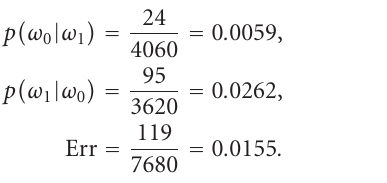
The error rate of DB4 is the